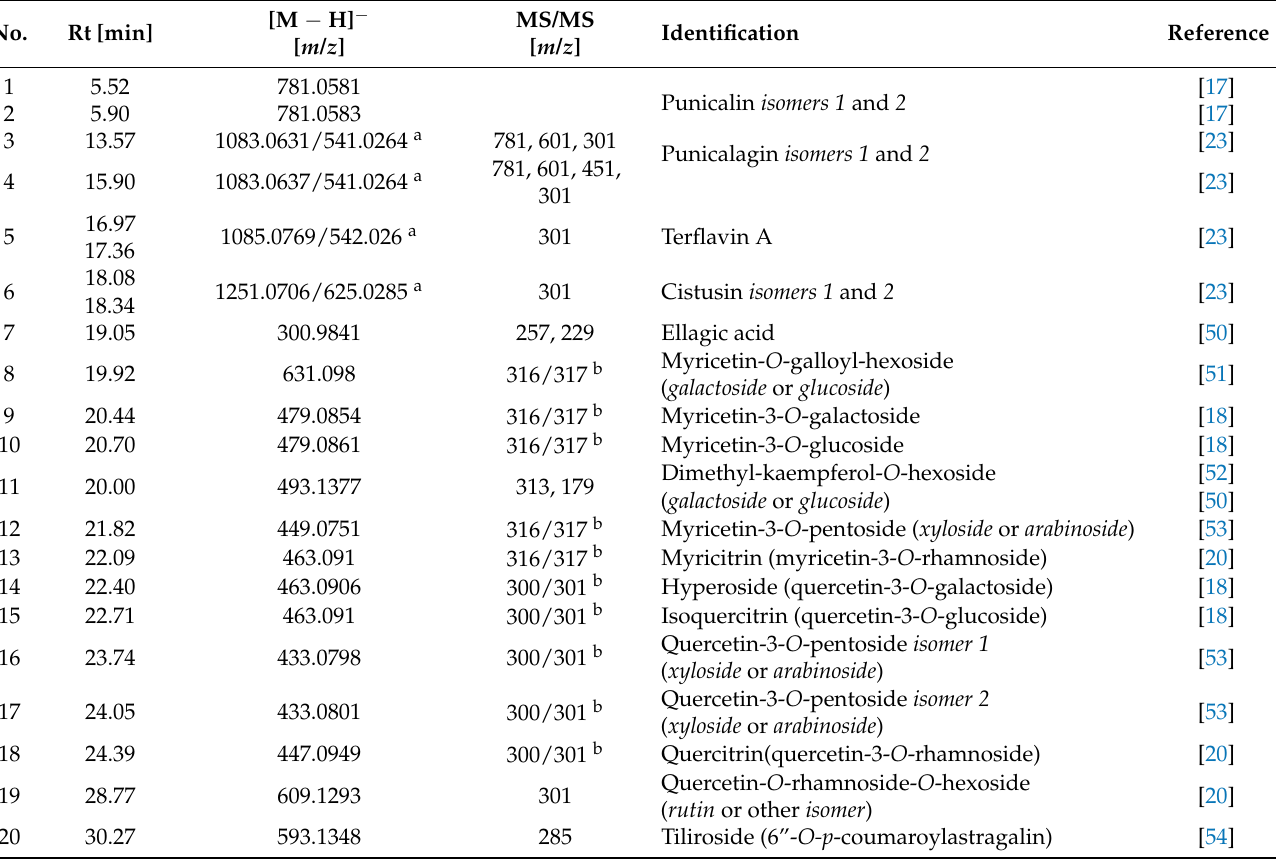
Table 2. UHPLC-ESI-MS data of C. incanus infusion components in negative ion